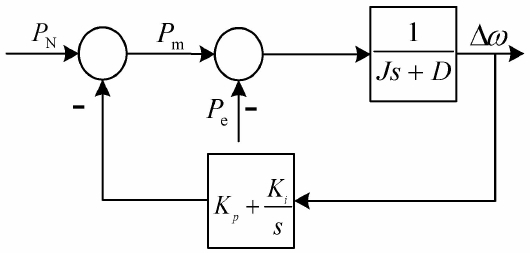
Figure 6. Simplified block diagram of the primary and secondary FM principle of the system.